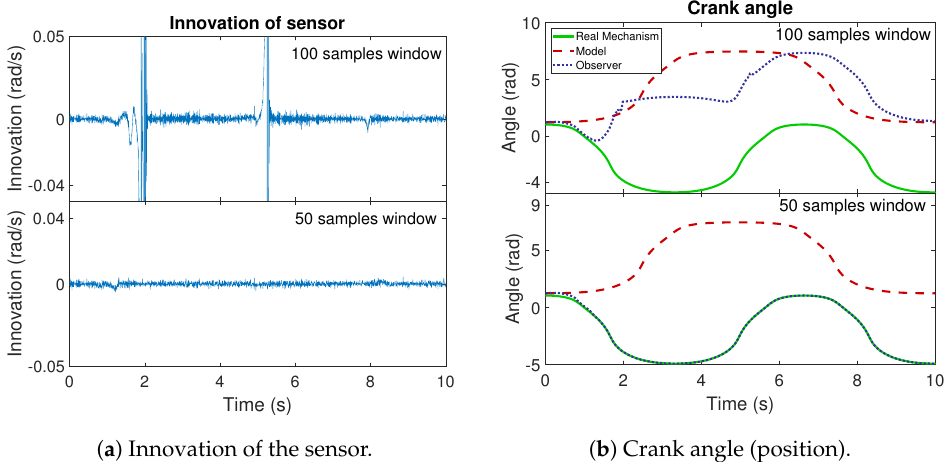
Figure 5. Comparison of innovation and crank angle for the simulation of the four-bar linkage with a gyroscope on the coupler for different window